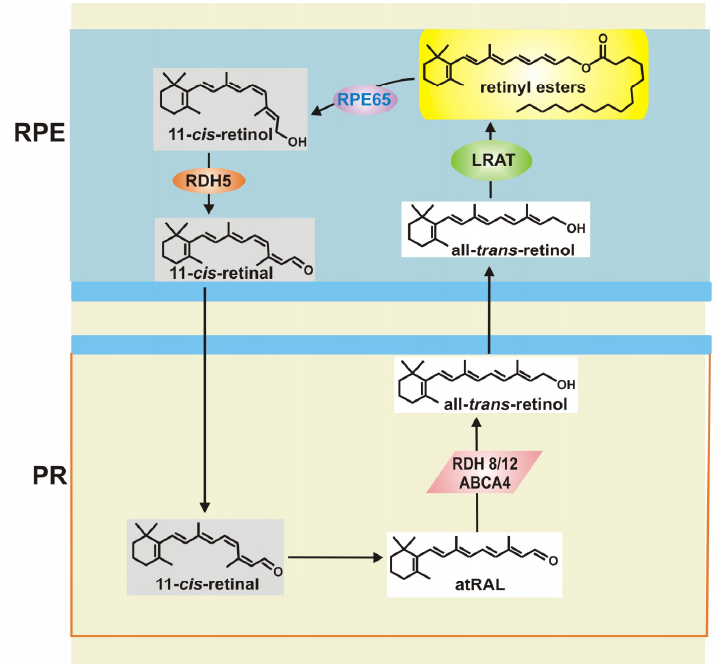
Figure 2. The visual cycle produces all- trans -retinal (atRAL), which is a major cellular waste in retinal cells. Light is absorbed by photoreceptors (PR) and causes isomerization of 11- cis -retinal to atRAL, which is transported and reduced to all- trans -retinol by ATP-binding transporter (ABCA4) and all trans retinal dehydrogenases RDH8/12, respectively. atRAL moves into retinal pigment epithelium (RPE), where it is converted to all- trans -retinyl esters by lecithin retinol acyltransferase (LRAT). RPE-specific protein (RPE65) isomerized these esters to 11- cis -retinol, which is then oxidized by RDH5 to 11- cis -retinal. Black arrows indicate a way from a compound to its derivative.